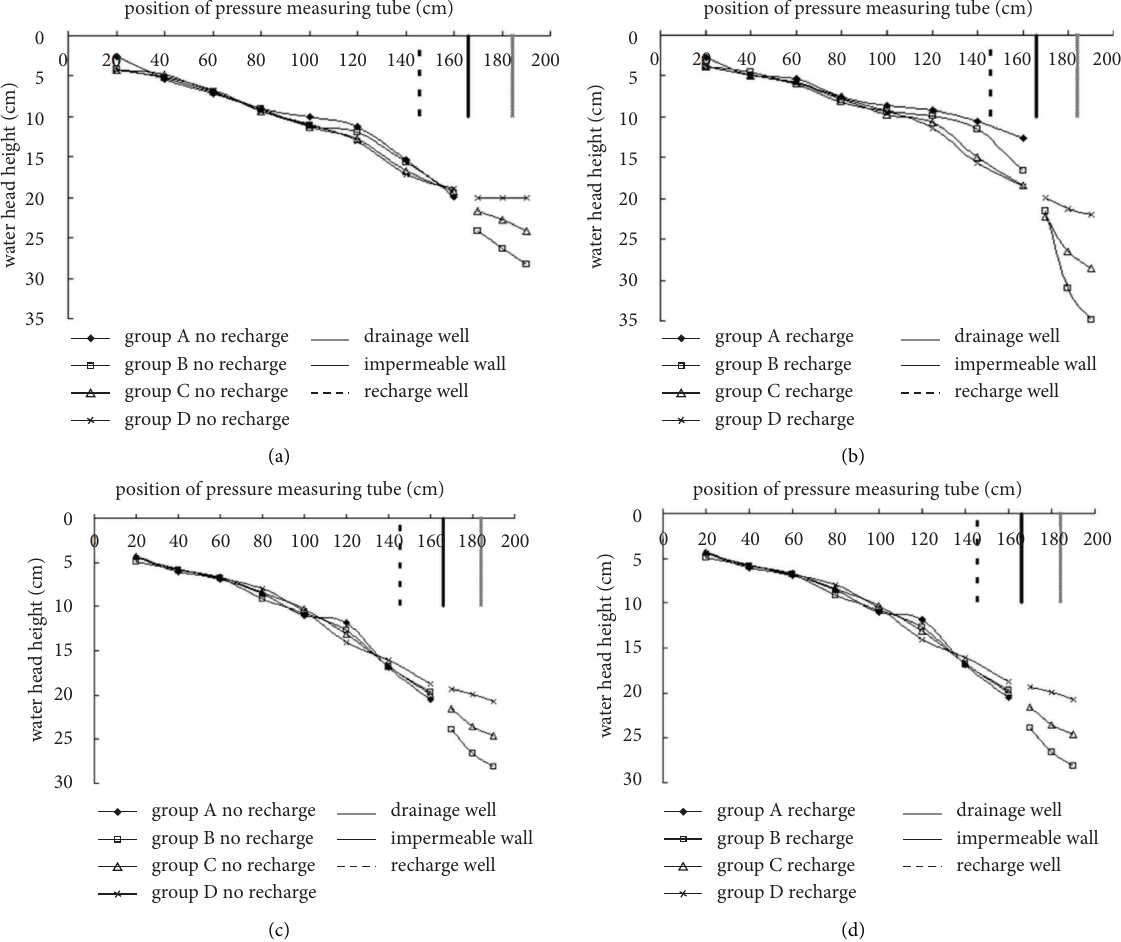
Figure 5: Variation laws on groundwater level in the stratum under two working conditions with and without recharge. (a) Variation of water level on the outside (the side with wells) with distance excluding recharging. (b) Variation of water level on the outside (the side with wells) with distance under recharging. (c) Variation of water level on the outside (the side with no well) with distance excluding recharging. (d) Variation of water level on the outside (the side with no well) with distance under